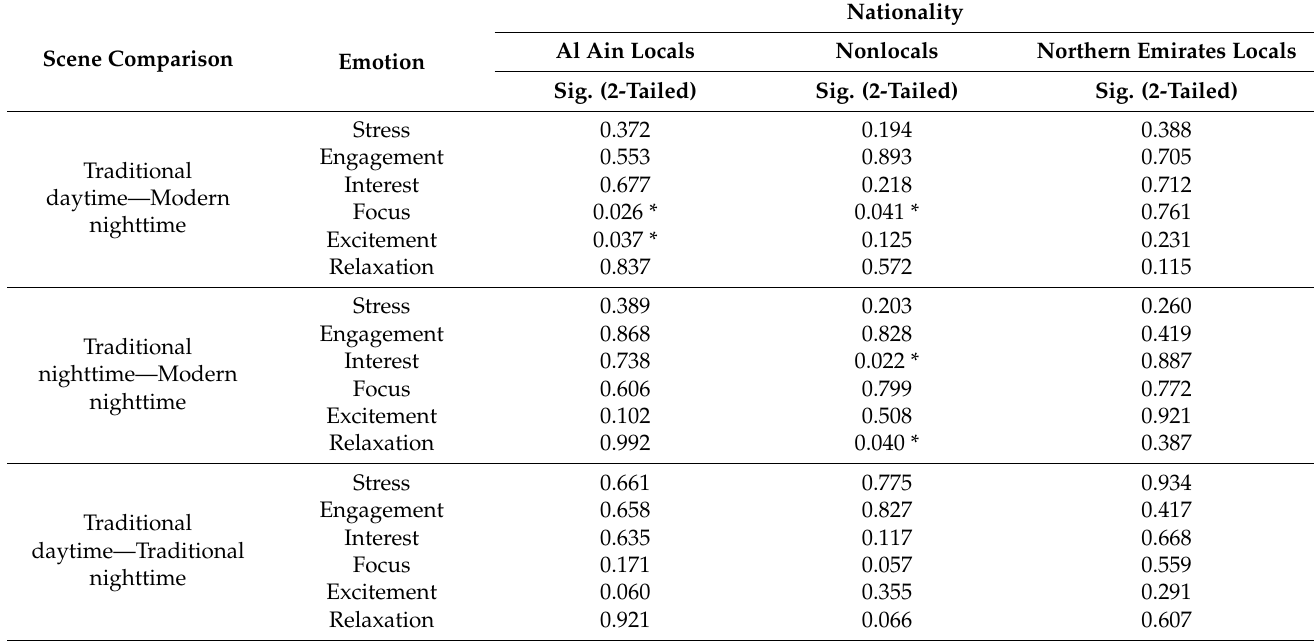
Table 6. Summary of the bootstrap results for the paired-samples t -tests for all